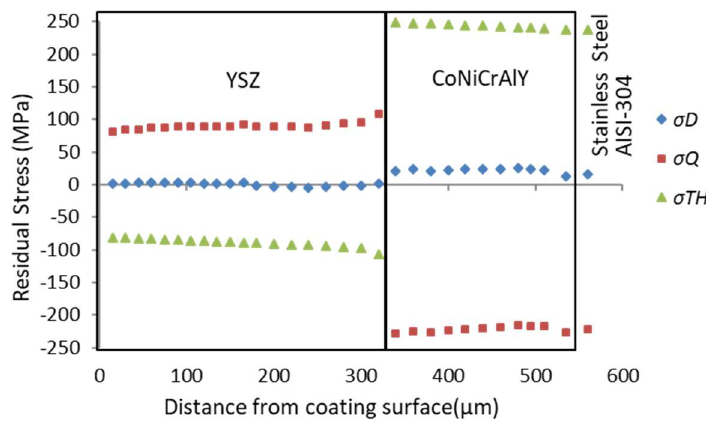
Figure 3. Residual stress caused by TBC deposition.